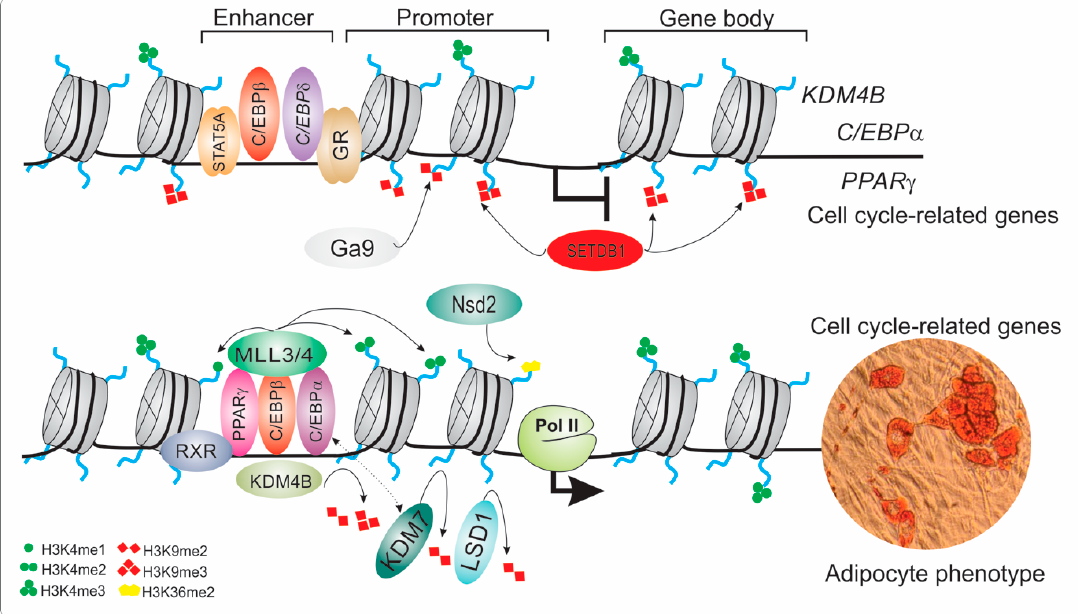
Figure 3. Epigenetic regulation of mesenchymal stem cells during adipocyte differentiation. The Epigenetic regulation of mesenchymal stem cells during adipocyte di ff differentiation of mesenchymal stem cells into adipocytes is driven by cooperative transcription factors and epigenetic remodelers that act to modulate the chromatin landscape. The recruitment of early adipogenic factors such as C/EBP β , C/EBP δ as well other transcription regulators (STAT5A, GR) to regulatory elements (enhancers) is mediated by resolving bivalent H3K4me3 and H3K9me3 marks to a monovalent active mark, H3K4me3. The early transcription factor C/EBP β stimulates the expression of KDM4B , which in turn serves as a cofactor of C/EBP β to facilitate the transcriptional activation of cell cycle-related genes by removing H3K9me3 marks and recruiting MLL3/4 to establish active enhancers. In addition, KDM4B and LSD1 remove H3K9me2 and H3K9me3 (deposited by